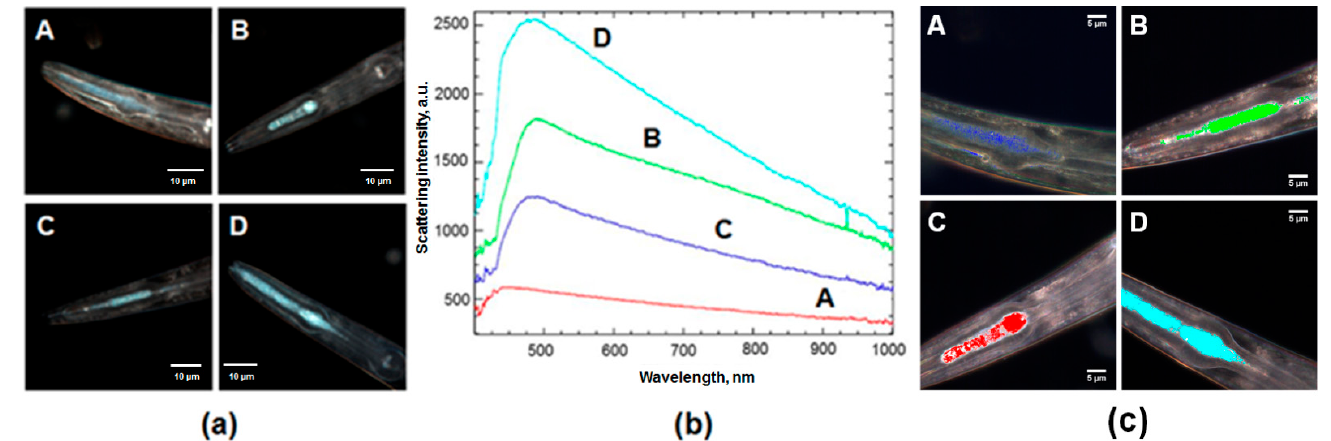
Figure 5. ( a ) Dark-field images and ( b ) the corresponding spectral curves of nematodes feed with: A—pristine halloysite, B—CdS/HNT-Azine, C—Cd 0.7 Zn 0.3 S/HNT-Azine, D—CdS/HNT-NH 2 , ( c ) Hyperspectral mapping of nematodes feed with: A—pristine halloysite, B—CdS/HNT-Azine, C—Cd 0.7 Zn 0.3 S/HNT-Azine, D—CdS/HNT-NH 2 .